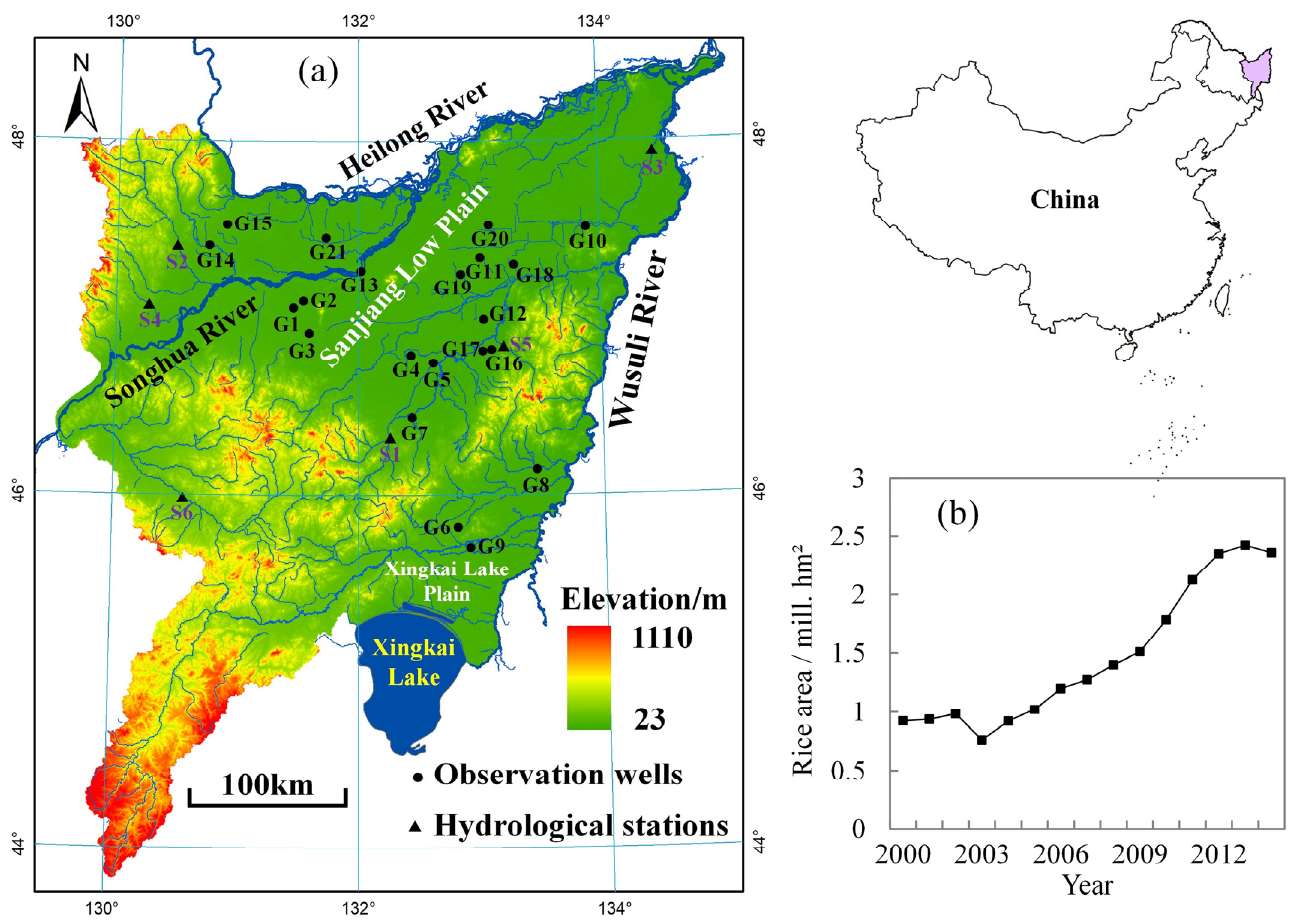
Figure 1. ( a ) Overview of Sanjiang Plain; ( b ) rice area change.